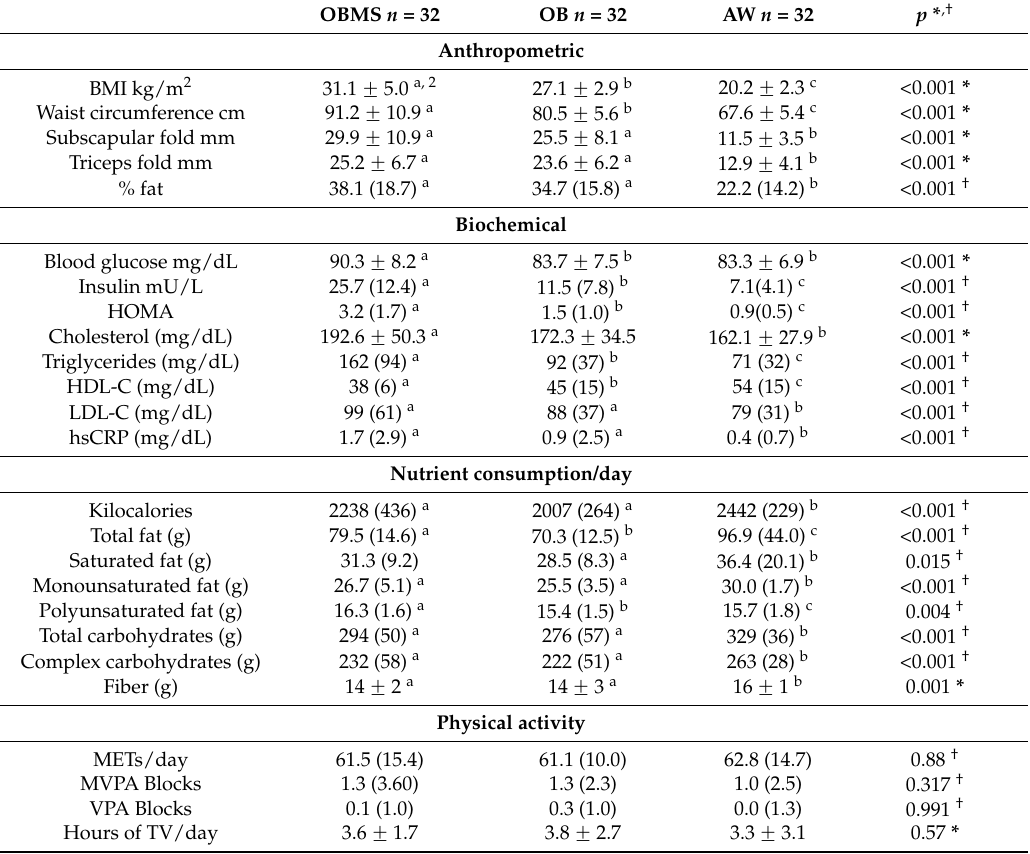
Table 2. Anthropometric, biochemical, food intake and physical activity variables of the study groups 1 .